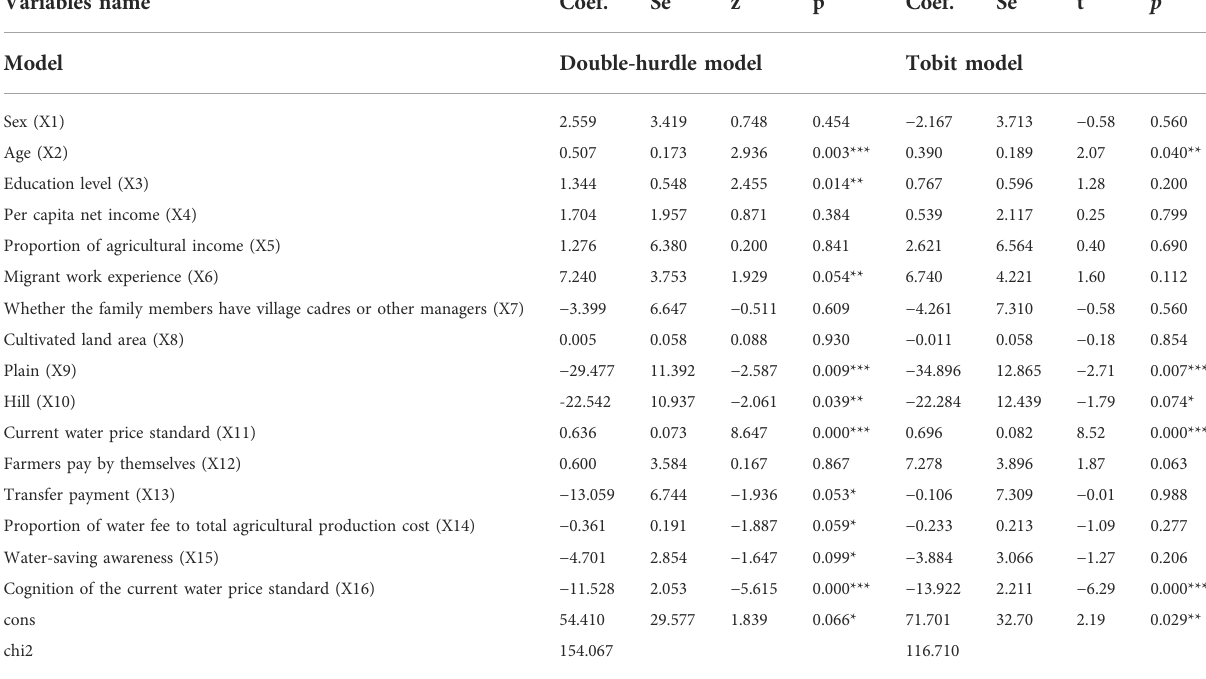
TABLE 6 In fl uencing factors for price